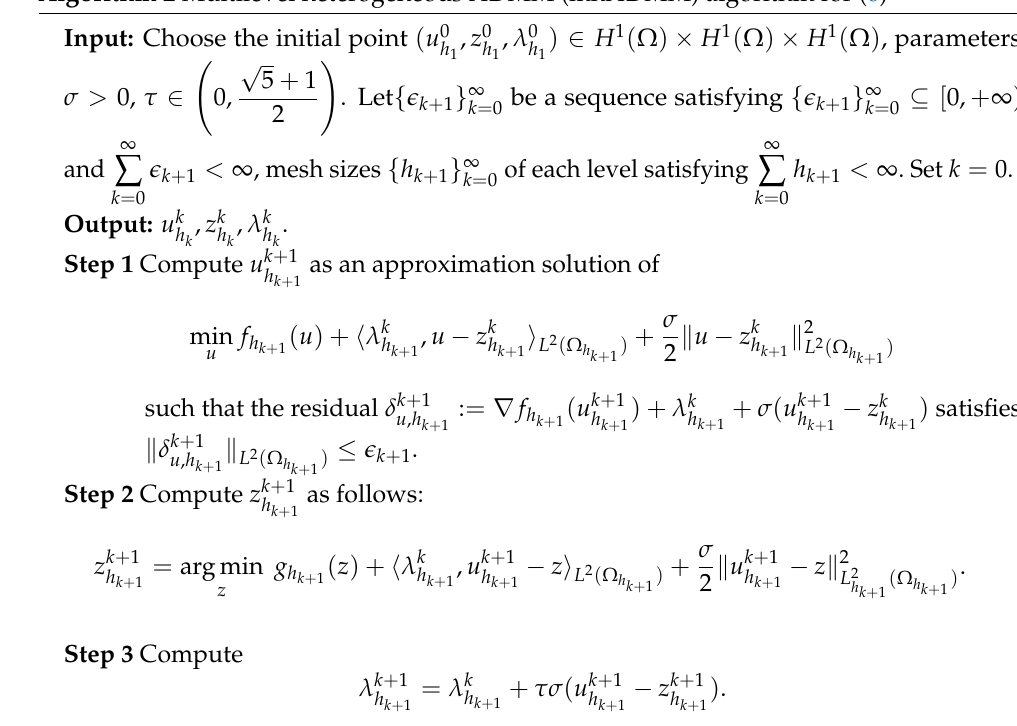
Algorithm 2 Multilevel heterogeneous ADMM (mhADMM) algorithm for